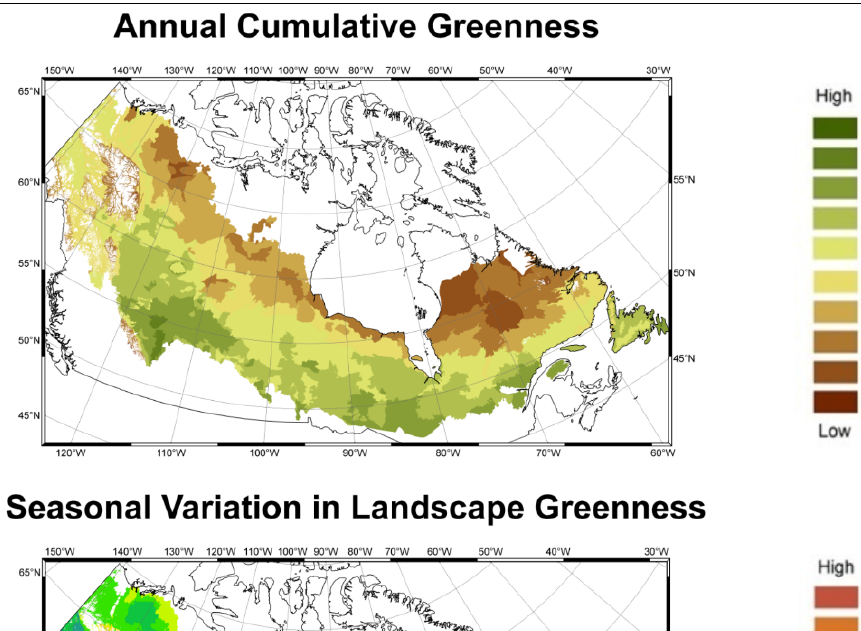
Figure 2. The three fraction of photosynthetically active radiation (fPAR) indices that represent vegetation productivity and are combined to produce the dynamic habitat index (DHI): annual cumulative greenness; seasonal variation in greenness; and minimum annual cover. Annual cumulative greenness is an indication of overall vegetation productivity and the potential productivity at any given location. Seasonal variation in greenness is calculated as the coefficient of variation and is sensitive to extreme changes in vegetation cover. Minimum annual cover indicates the lowest amount of vegetated cover at a specific location within a year. Maps shown represent conditions in